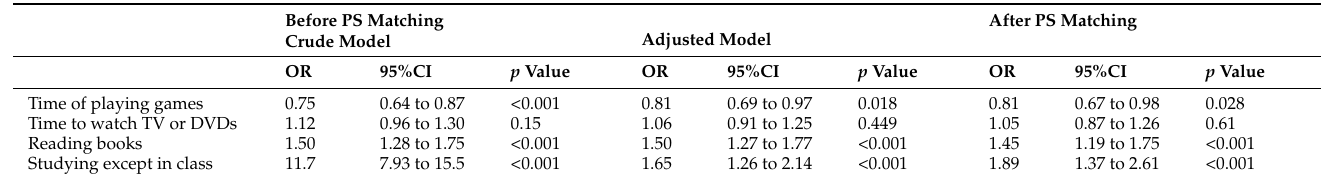
Table 4. Statistical results of time usage before and after propensity score